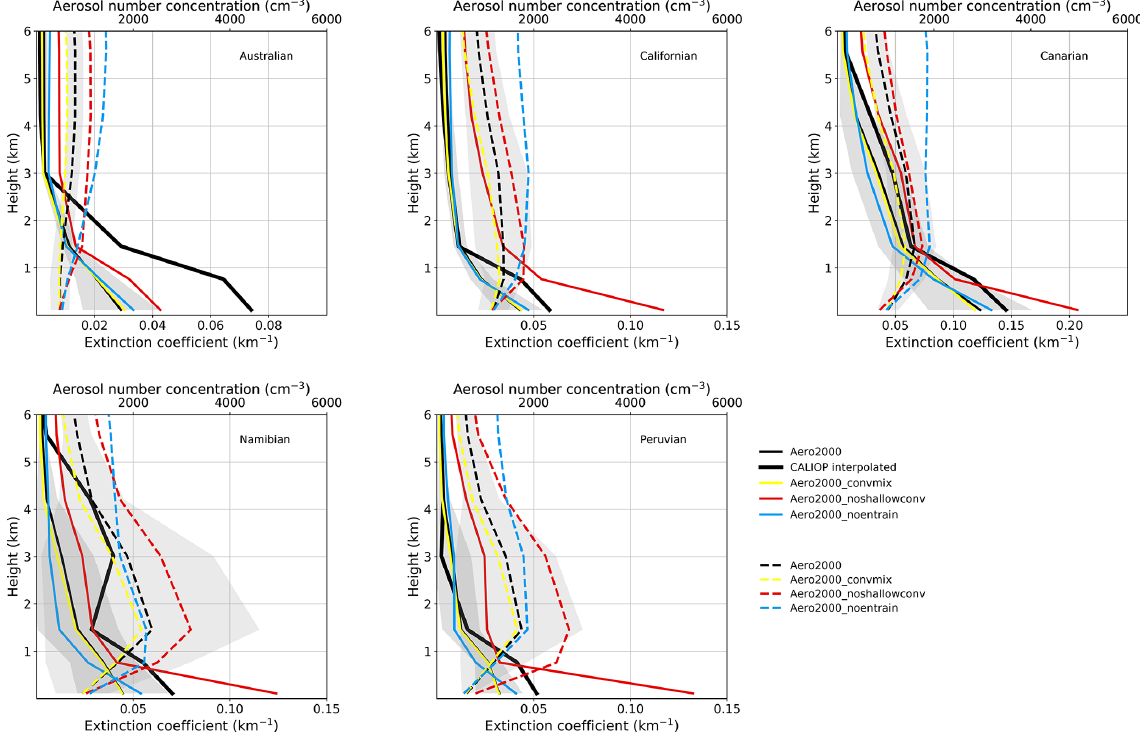
Figure 8. Vertical distribution of the aerosol extinction coefficient (km − 1 ; solid line) and aerosol number concentration (cm − 3 ; dashed line) for the Australian, Californian, Canarian, Namibian, and Peruvian regions for the model control simulation and sensitivity experiments in the category transport. The SD of the model control simulation is indicated as a grey shaded